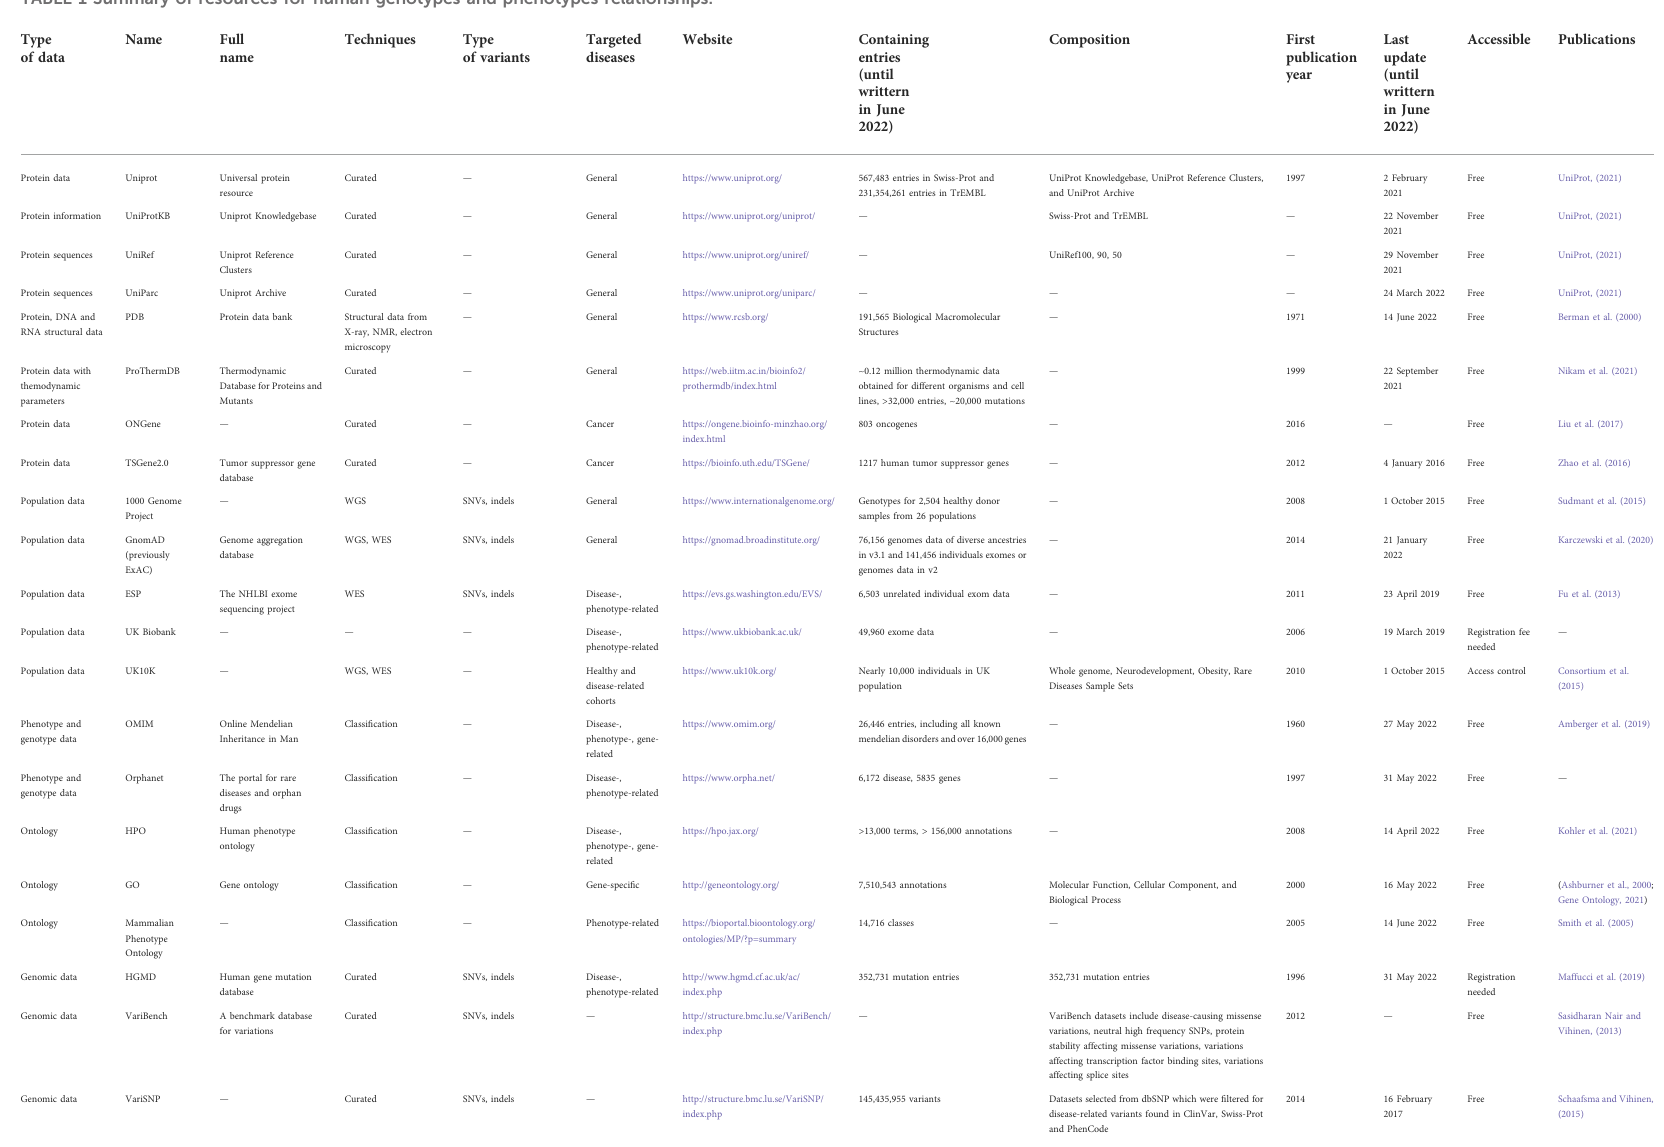
TABLE 1 Summary of resources for human genotypes and phenotypes relationships. Type of